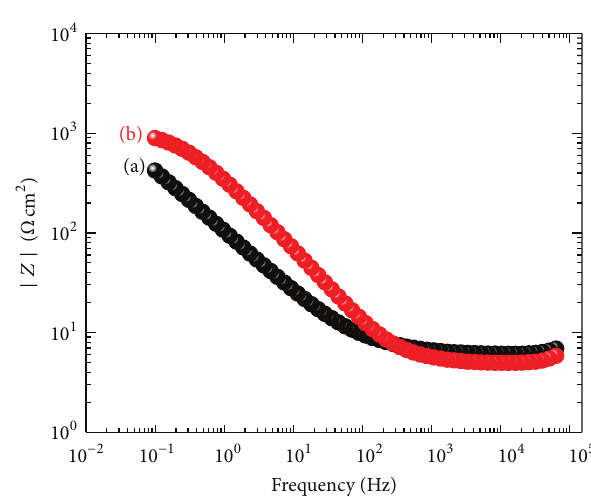
Figure 4: Bode impedance plots obtained for the API X70 pipeline steel after its immersion for (a) 1h and (b) 20 h in Arabian Gulf